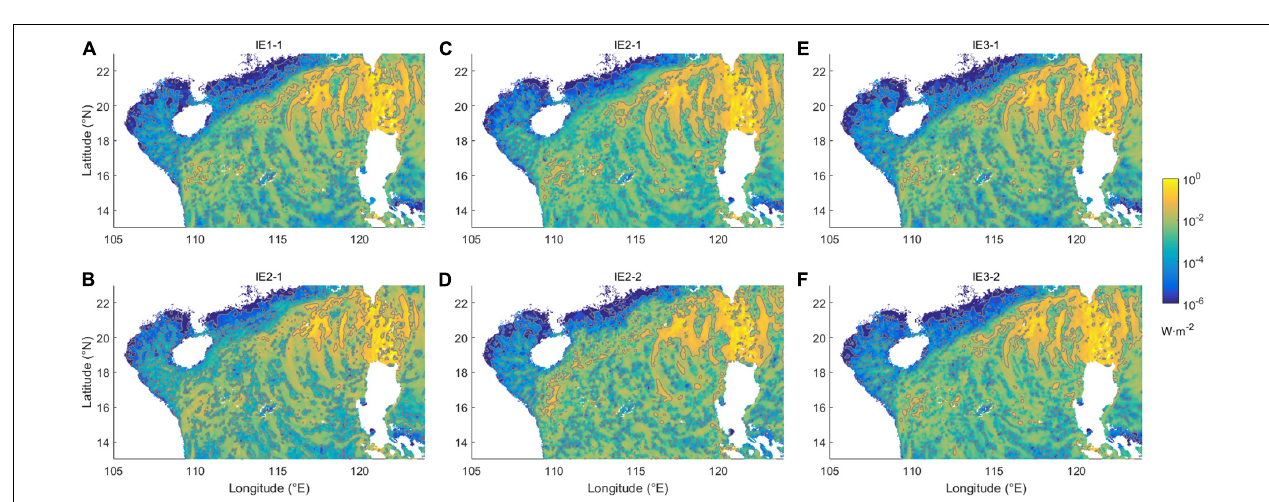
FIGURE 5 | Depth-integrated dissipation rate (gray lines indicate dissipation of 0.5 Wm − 2 ) for (A,B) IE1, (C,D) IE2, and (E,F) IE3.